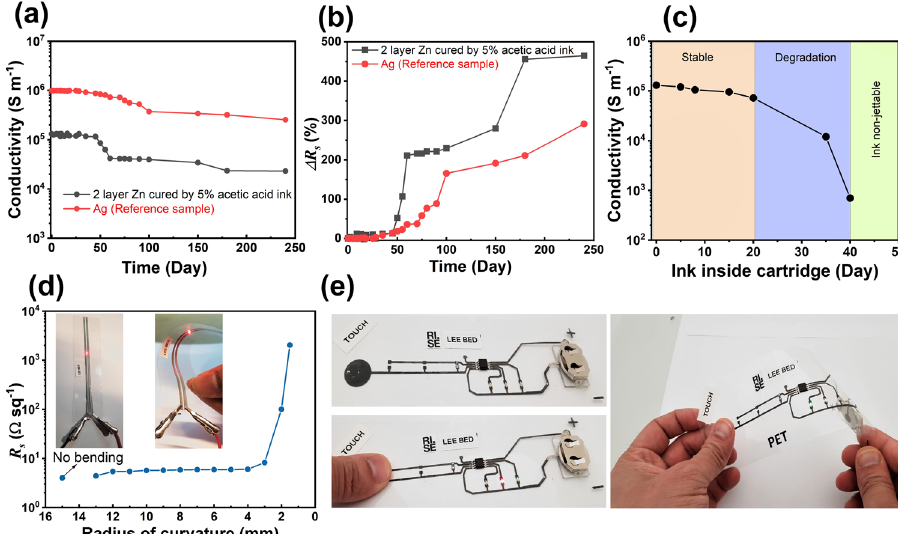
Fig. 4 Stability and demonstration. a Electrical conductance variations of chemically cured Zn patterns with time, where a printed Ag sample is shown as a reference. The Ag sample is cured at 120 °C for 30 min. b Percentage change of R s for chemically cured Zn patterns with time. A printed Ag sample is shown as a reference. c Change of electrical conductance for Zn patterns printed with the same cartridge for several consecutive days. Lines are guides for the eye. d Variation of the sheet resistance of cured samples bent with different radii of curvature (Inset: mechanical fl exibility of the cured Zn electrodes printed on PET substrates. The LED is mounted on top of the 2 parallel Zn tracks). e A demonstrator circuit on PET substrate with a touch sensor, mounted LEDs, a microcontroller, and